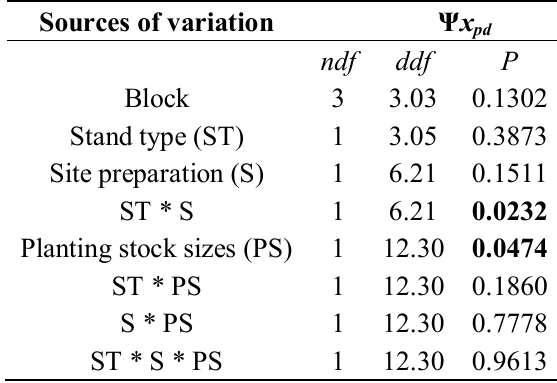
Table 4. Summary of ANOVA (degrees of freedom and p -values) for August predawn shoot water potential (Ψ x ) during the first growing season after plantation, of black spruce seedlings planted in lichen woodlands and black spruce feather-moss stands, in scarified or unscarified plots and with smaller (126-25) or larger (67-50) containerized stock size. Sources of variation